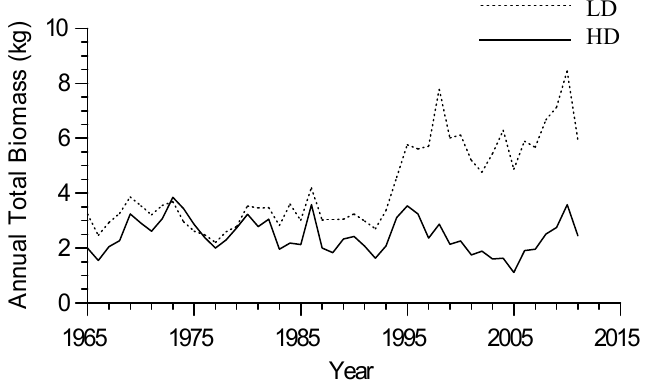
Figure 4. The average annual total aboveground biomass of trees in low density (dashed line) and high density (solid line)